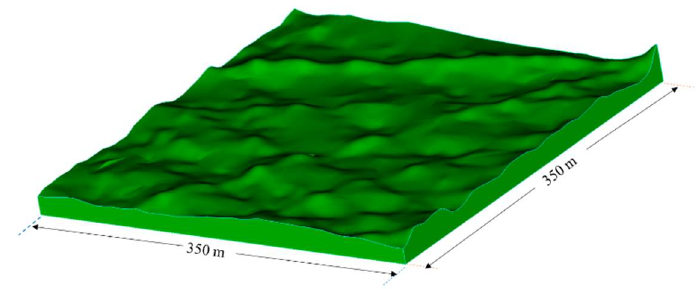
Figure 7. The 3D ocean geometry with the size of 350 350 m m .